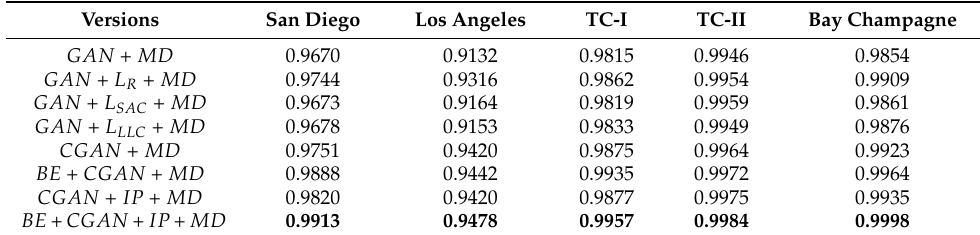
Table 4. AUC values of eight algorithm versions on the data